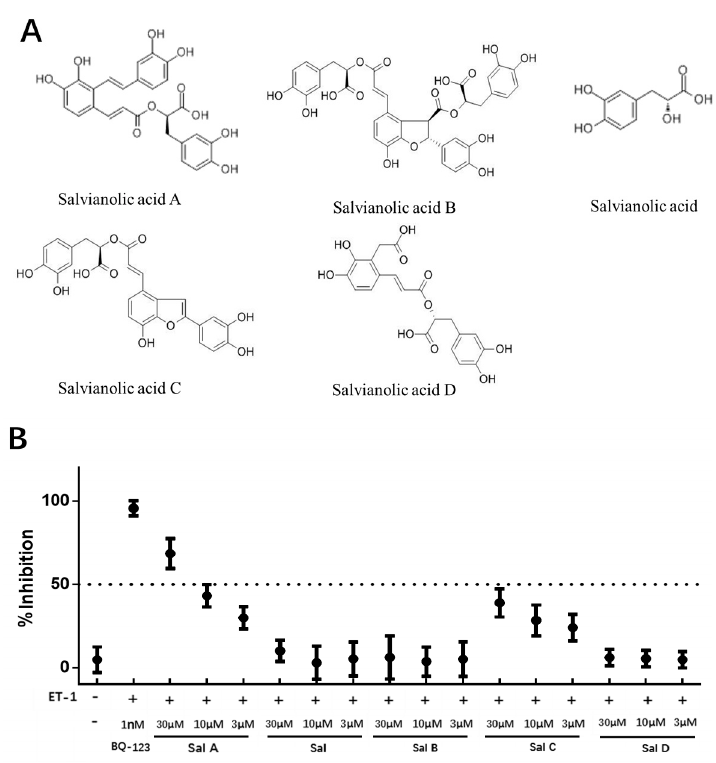
Figure 2. The primary evaluation of five compounds in HEK293/ET A R cell line. ( A ) Chemical formulas of Salvianolic acid A, Salvianolic acid B, Salvianolic acid C, Salvianolic acid D, Salvianolic acid; ( B ) Inhibitory responses of the five tested compounds in HEK293/ET A R cell line. The cells were pre-incubated with tested compounds for 10 min and then stimulated by 20 nM ET-1. Data (mean ± SD) were expressed as inhibition (%) from two independent experiments.